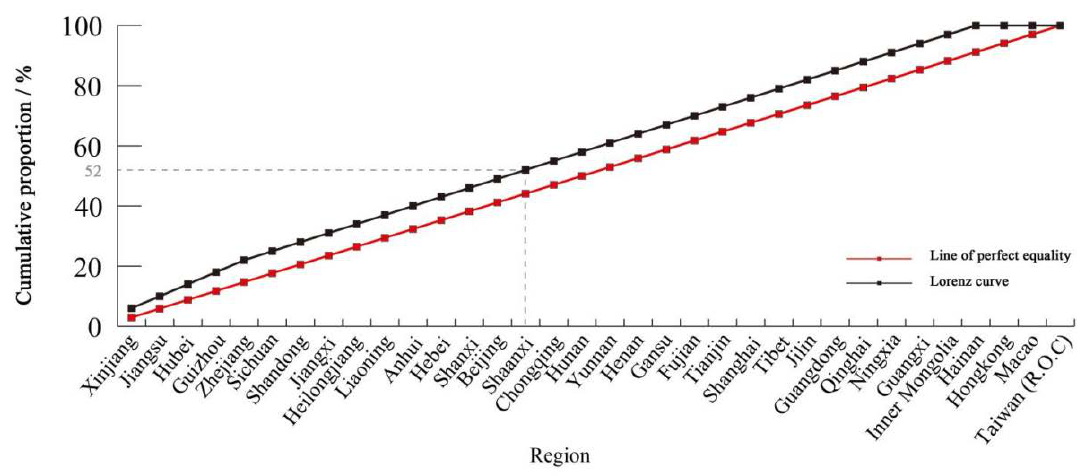
Figure 5. The Lorenz curve of NRTTC.